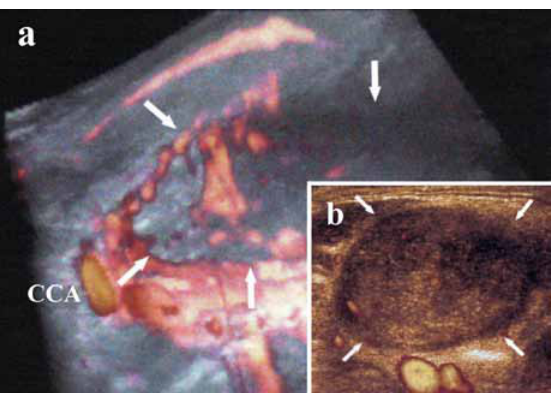
Figure 1. a: 3DCDS indicated the presence of hypoechogenic and partially heterogenic formation (white arrows) with demar- cated margins, located in the right lateral neck area, above CCA, b: and in front of the ICA and ECA